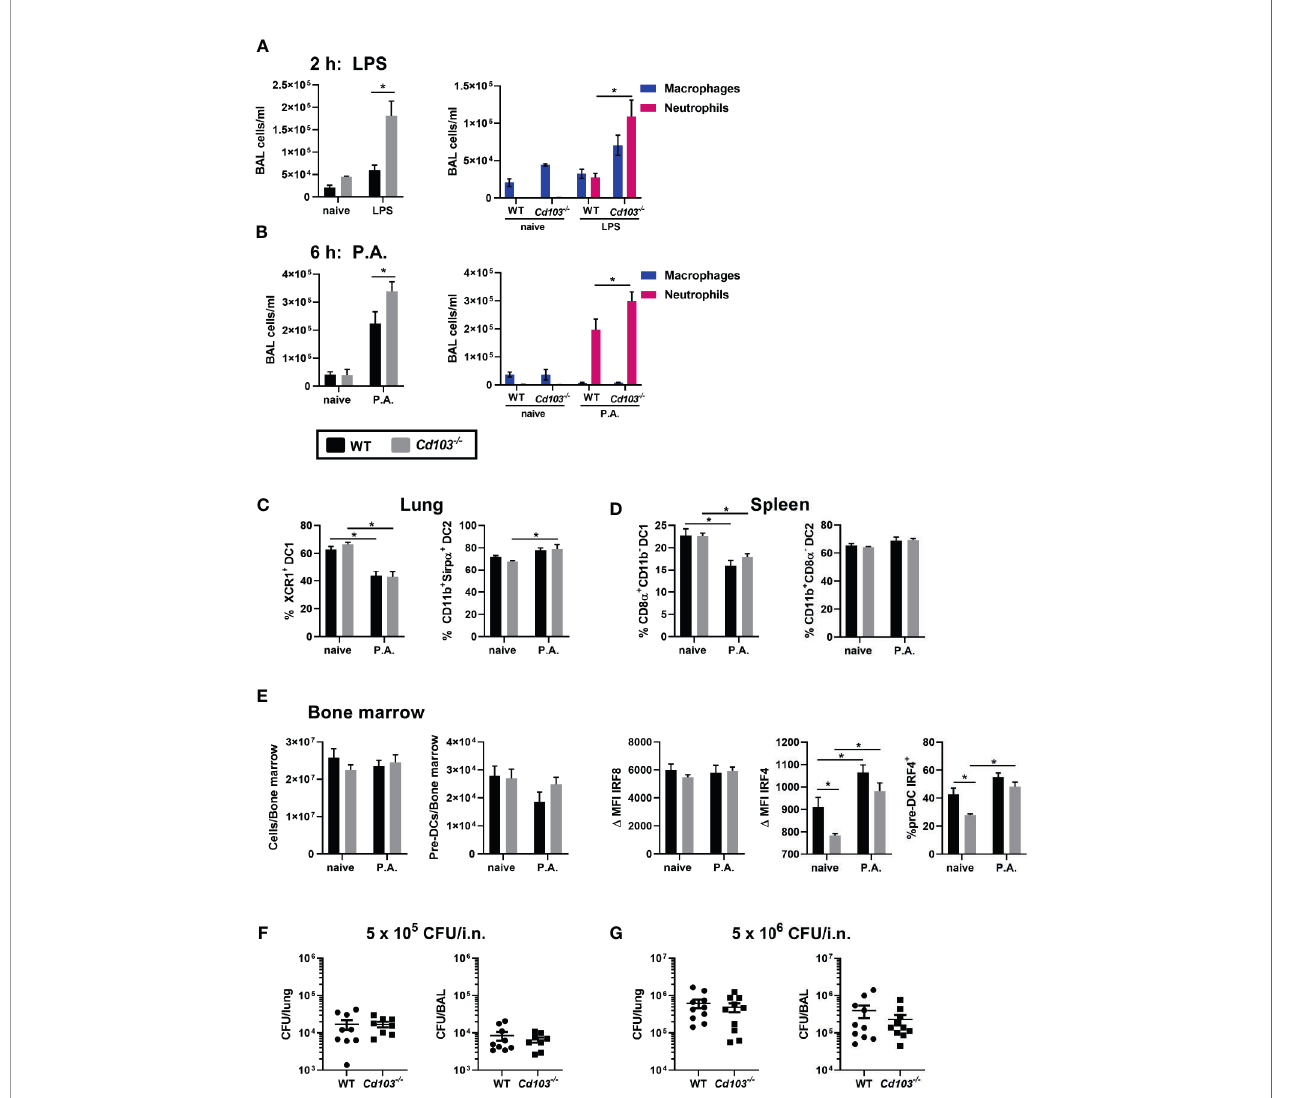
FIGURE 5 | Lack of CD103 expression favors the recruitment of bronchoalveolar neutrophils. (A, B) Total number ( fi rst panel), macrophages and neutrophils (second panel) of bronchoalveolar lavage (BAL) cells were compared between WT and Cd103 -/- mice (A) 2 h following LPS i.n. instillation or (B) 6 h following i.n. instillation of 5 x 10 5 CFU of P. aeruginosa (P.A.). (C – E) Lung, spleen and bone marrow cells were analyzed by fl ow cytometry 18 h after i.n. instillation with 5 x 10 5 CFU of P. aeruginosa. (C) Percentage of XCR1 + cDC1s and percentage of CD11b + Sirp a + cDC2s in lung. (D) Percentage of CD8 a + CD11b + cDC1s and percentage of CD11b + CD8 a - cDC2s in spleen. (E) Total cell number, pre-DC number, D IRF8 MFI, D IRF4 MFI and percentage of IRF4 + pre-DCs in bone marrow. (F, G) P. aeruginosa CFU number present in the lung and BAL 6 h after i.n. instillation of (F) 5 x 10 5 CFU or (G) 5 x 10 6 CFU of P. aeruginosa. Data are presented as mean ± SEM; (A) n = 2-5 (naive-P.A.) representative of two independent experiments. (B) n = 3-10 (naive-P.A.) pooled from two separate experiments. (C – E) (total and pre-DC number) (F, G) n = 9-10 pooled from two separate experiments. (E) (IRF4-IRF8) n = 5 representative of two independent experiments. *p < 0.05 using two-way